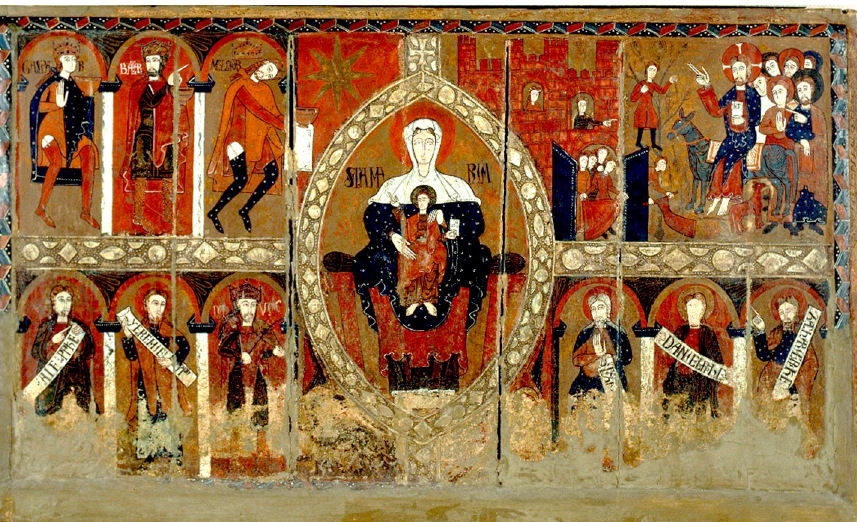
Arts 2021 , 10 , x FOR PEER REVIEW Figure 12. Altar frontal from Sant Vicenç d’Espinelves, c. 1187 (MEV 7). © Museu Episcopal de Vic.